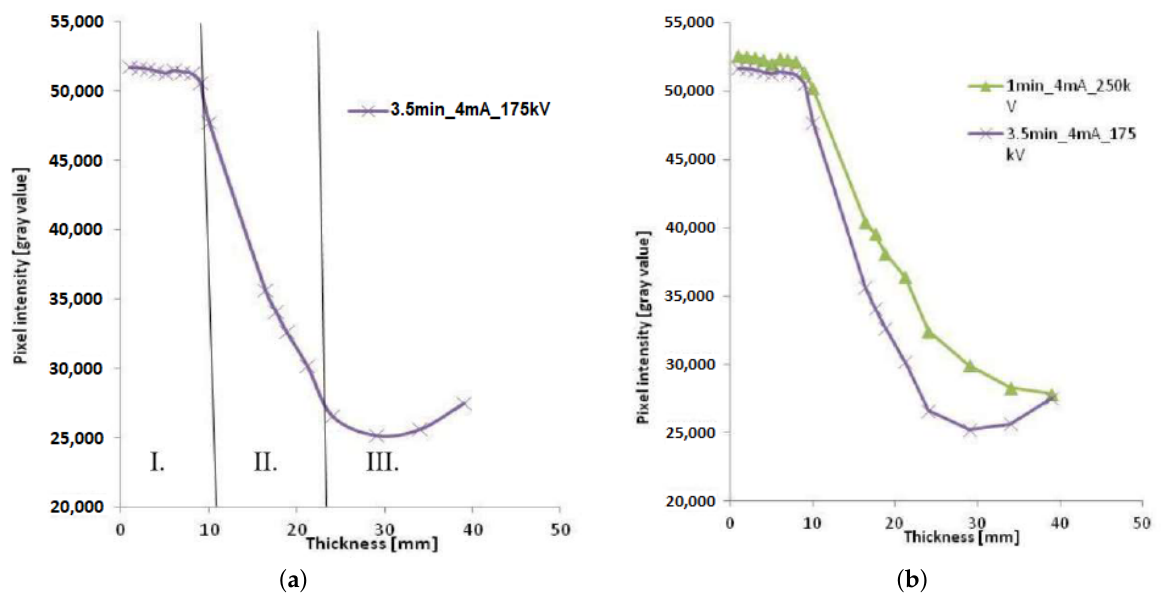
Figure 45. ( a ) The relationship between the pixel intensities of the radiographic film and the thickness of the wall of a pipeline at 175 kV tube voltage. ( b ) The comparison of the relationships between the pixel intensities of the radiographic film and the thickness of the wall of a pipeline at 175 kV and 250 kV tube voltage. Reprinted under Creative Commons CC BY-NC-ND license